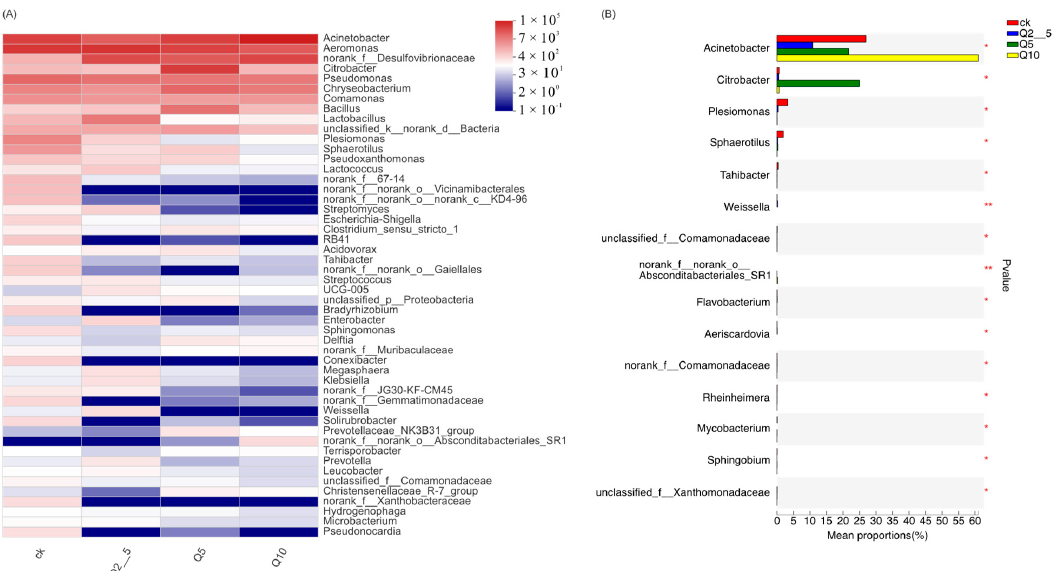
Figure 2. ( A ) Heat map of different genes. Heat map showing differences at the genus levels. The horizontal direction is the sample information and the vertical is the annotation information for genus and species. Red indicates a higher relative species abundance and blue indicates a lower relative species abundance. ( B ) Genes exhibiting differences in abundance among the four groups. The Y ‐ axis indicates the genes name at a given taxonomic level and the X ‐ axis indicates the mean relative abundance of the genes among the different groupings. The different colored bars indicate different groupings. The value on the right is the p ‐ value where p < 0.05 was considered statistically significant (* p < 0.05, ** p < 0.01). Samples were divided into four groups: CK, Q2.5, Q5, and Q10.